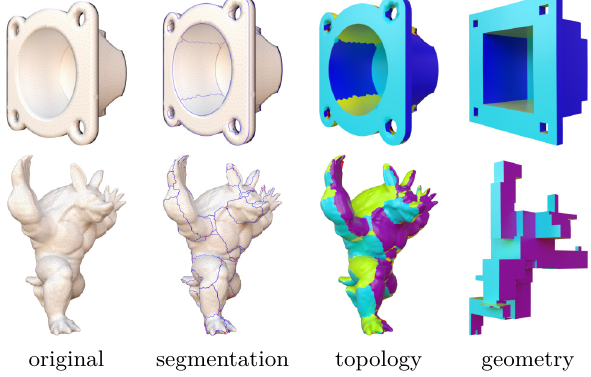
Fig. 1 Segmentation, polycube topology determination, and geometry